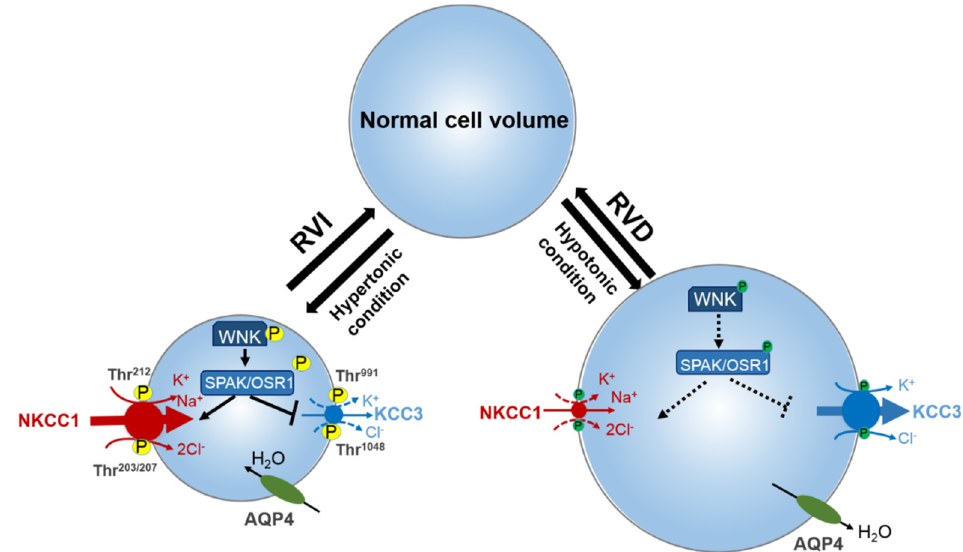
Figure 1. Roles of cation-chloride cotransporters (CCCs) in cell osmoregulation. Intracellular osmolarity changes activate cellular volume regulation. Under hypertonic extracellular conditions of cell shrinkage due to water extrusion from the cell, a counter-response of regulatory volume increase (RVI) restores normal cell volume. In this condition, the WNK-SPAK/OSR1 pathway is activated leading to the phosphorylation of the CCCs. This activates NKCC1 and inhibits KCC, leading to the NKCC1-mediated influx of Na + , K + , and Cl − along with water, thus restoring cell volume. On the contrary, under hypotonic stress conditions of cell swelling, the cell activates a regulatory volume decrease (RVD). The WNK-SPAK/OSR1 pathway remains inactive and NKCC1 and KCCs are dephosphorylated. This stimulates KCC3 but inhibits NKCC1 leading to the efflux K + and Cl − along with water, and cell volume decrease. NKCC1, K + -Cl − cotransporters; KCC3, K + -Cl − cotransporter 3; WNK, with-no-lysine kinase; SPAK, STE20/SPS1-related proline/alanine rich kinase; OSR1, oxidative stress response kinase; AQP4, aquaporin. Part of figure elements were adapted from Huang et al. [65].